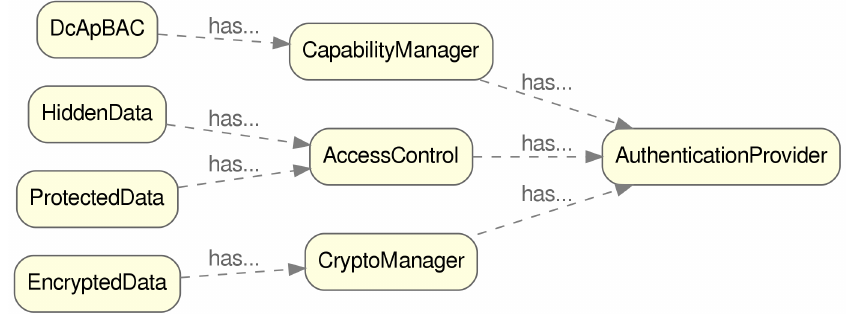
Figure 6. Object properties related to access